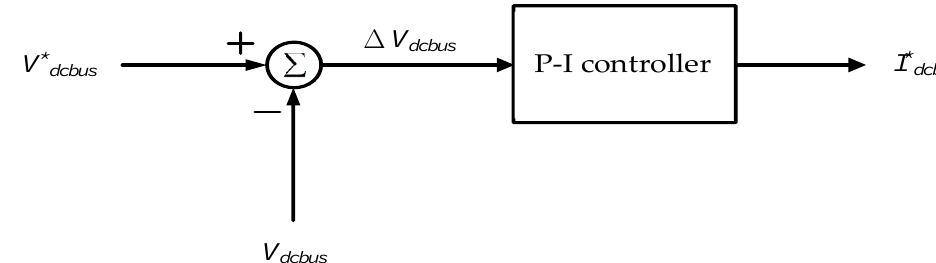
Figure 6. Control architecture of DC-link